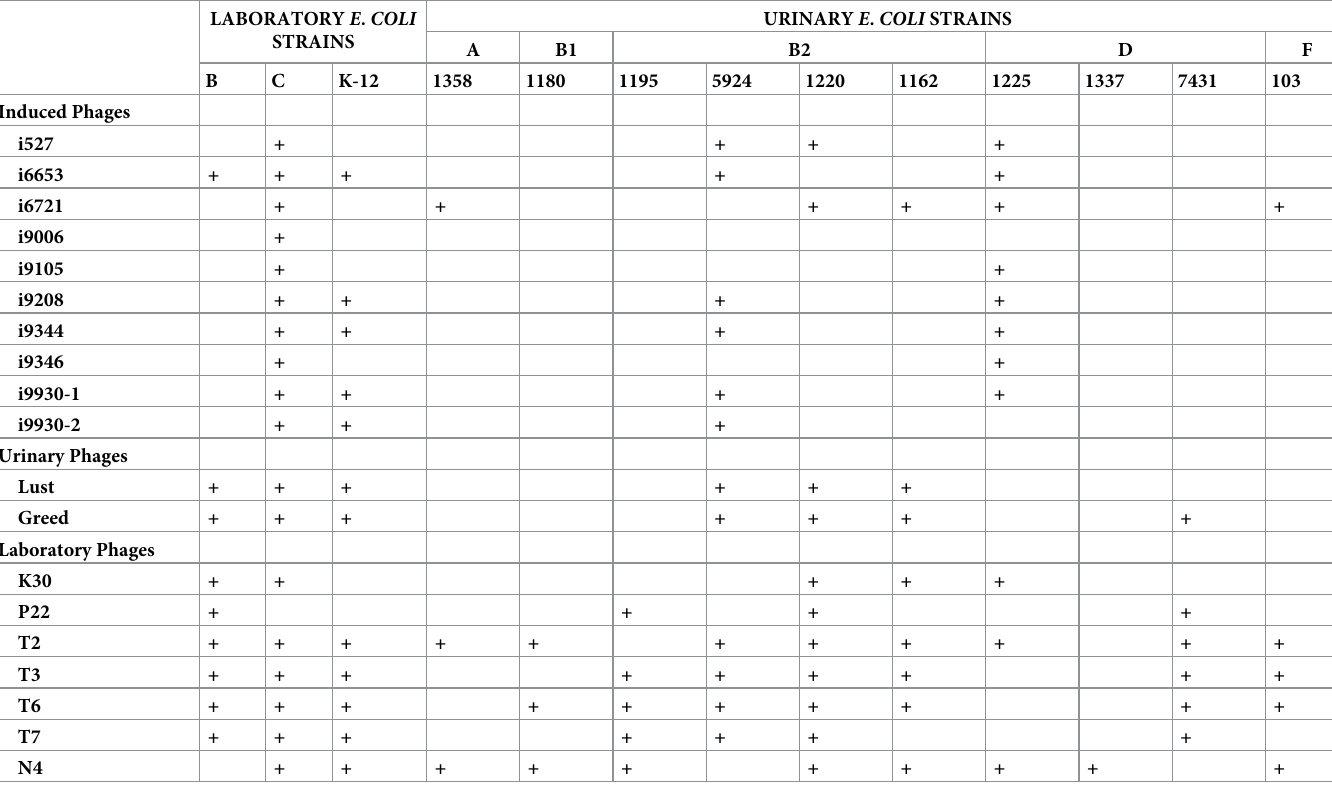
The well-studied phages T2 and N4 were most efficient in completely lysing E . coli strains isolated from UTI patients. Each was capable of completely lysing eight of the ten urinary Table 3. Phage efficacy of lysing laboratory and urinary bacteria. If a phage completely lysed the E . coli strain, the table lists “+”. The phylotype for each urinary E . coli strain is listed [7]. E . coli UMB0103 was isolated from a female with OAB symptoms; the other urinary E . coli strains were isolated from females with UTI symptoms. LABORATORY E . COLI